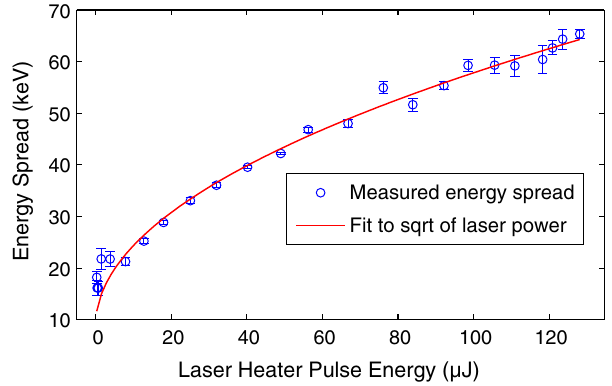
FIG. 9. Energy spread measured as a function of laser heater power. To determine energy spread, we measure the electron beam width in the dispersive region a few meters downstream from the laser heater. By increasing the energy of the laser heater, we are able to triple the energy spread of the electron beam. The energy spread increases as the square root of the laser heater power, except at low laser power where trickle heating causes a noticeable increase in the energy spread